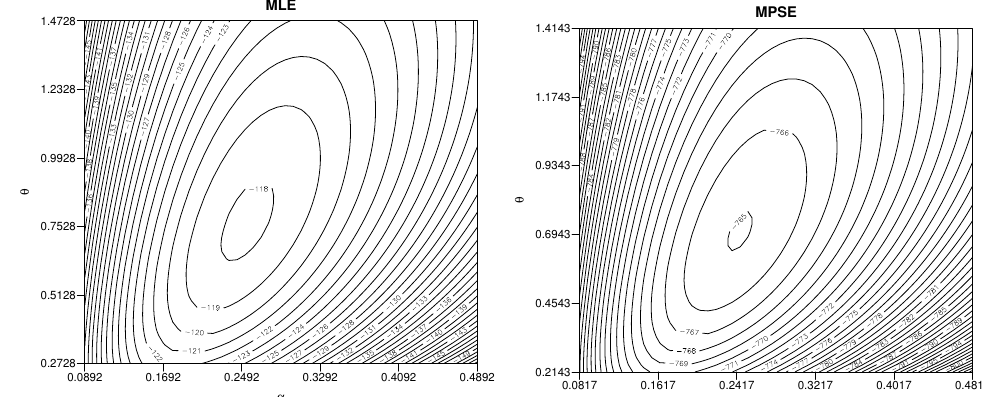
Figure 5. Contour plots of θ and α using the likelihood function ( left ) and MPE function ( right ) based on data set